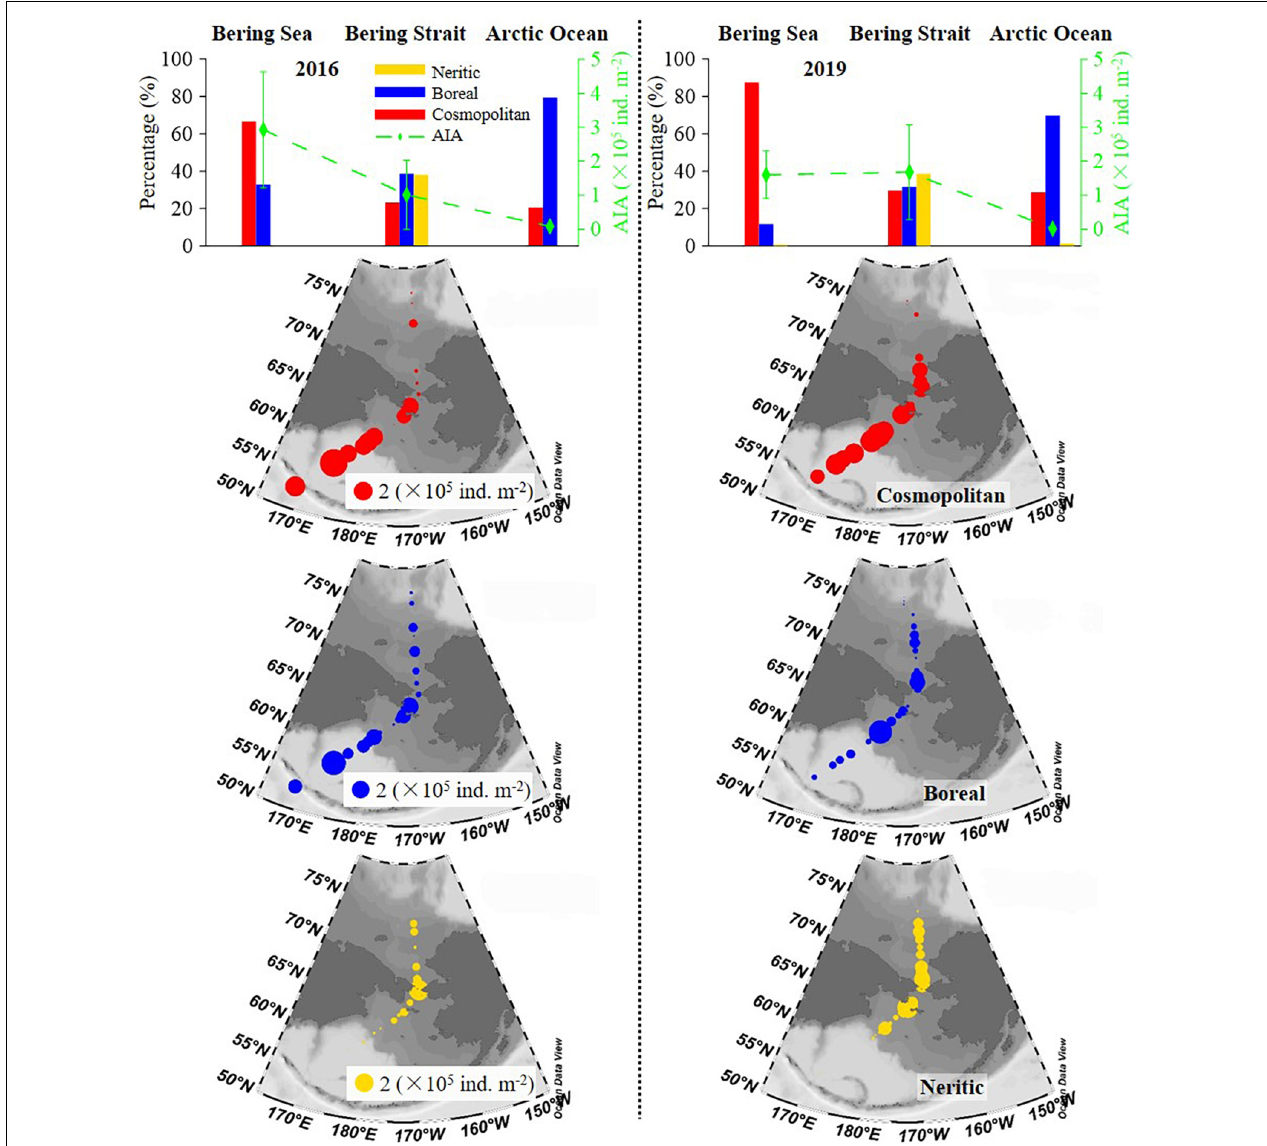
FIGURE 5 | Latitudinal variation of cosmopolitan, neritic, and boreal tintinnid (average) integrated abundance and its percentage. AIA, average integrated